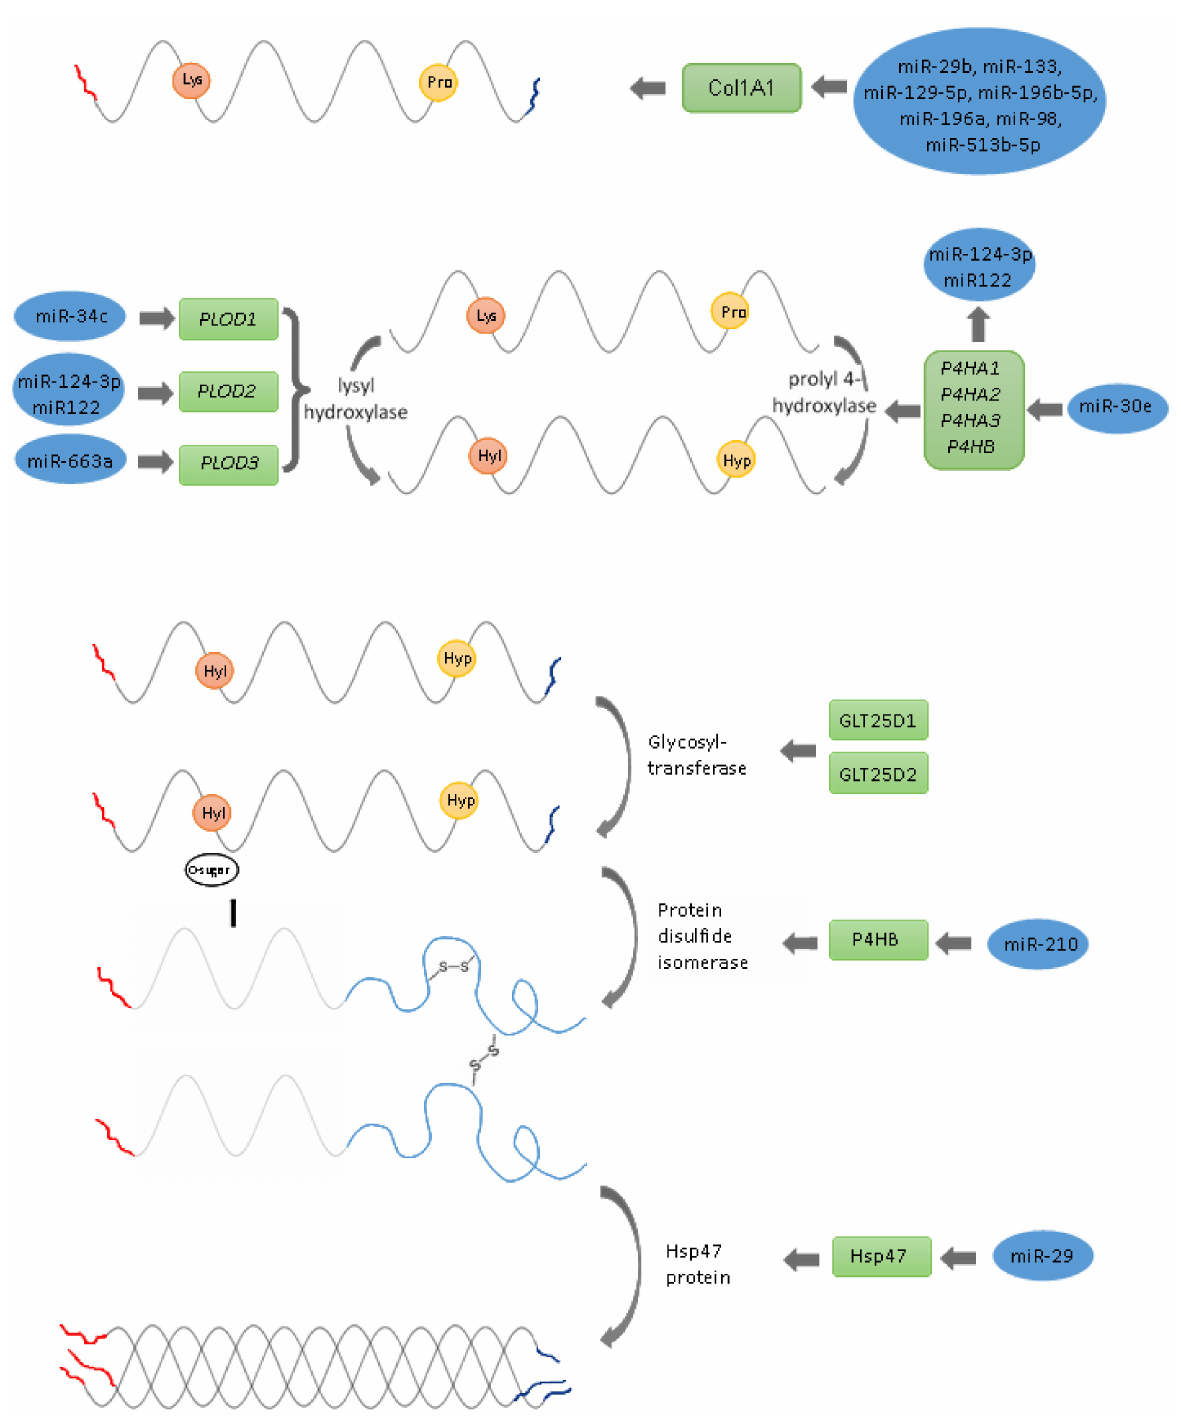
Figure 1. Schematic presentation of the key steps of collagen synthesis in the cell. miR-124 and miR-26 targets PLOD2 mRNA in regulating the malignant behaviours of laryngeal and renal carcinoma cells and is increased in osteoporotic patients’ blood [36,37,62]. In osteogenesis in vitro miR-26 regulates glycogen synthase kinase 3 β gene GSK3B [70]. PLOD3 is held by miR-663a, modulating collagen IV secretions in physiological conditions and in response to ER stress